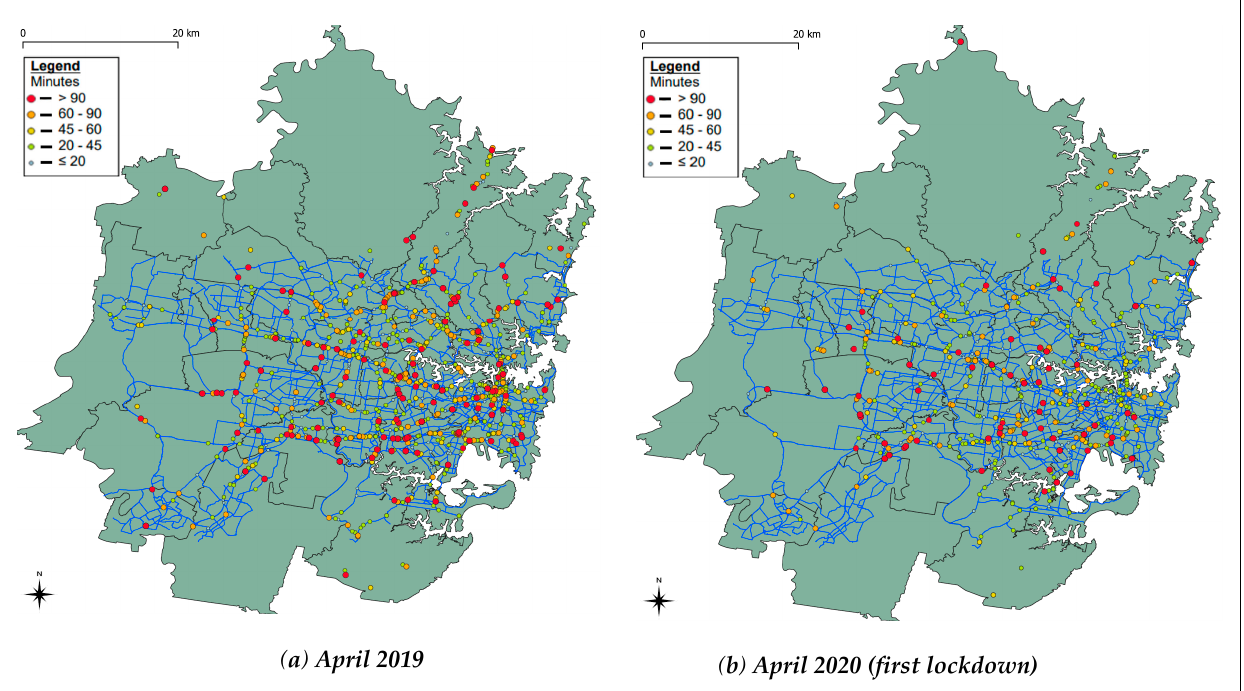
Figure 2. The comparison of incidents (breakdowns and crashes) in Sydney, colour-coded by duration. ( a ) During April 2019 and ( b ) during April 2020 (first lockdown).